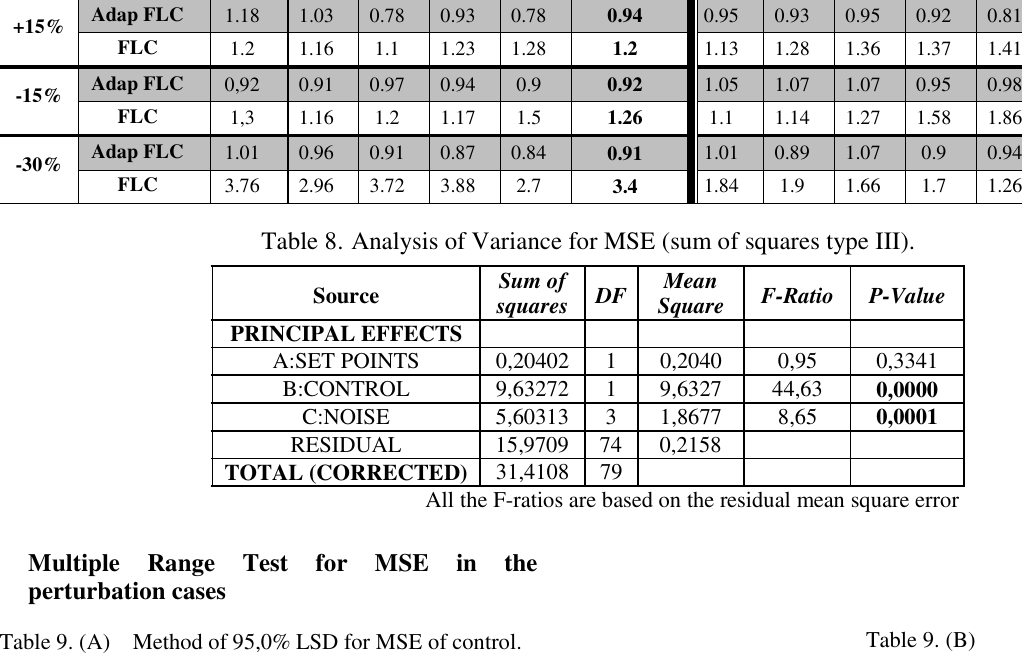
Table 9. (A) Method of 95,0% LSD for MSE of control. CONTROL Cases Mean LS